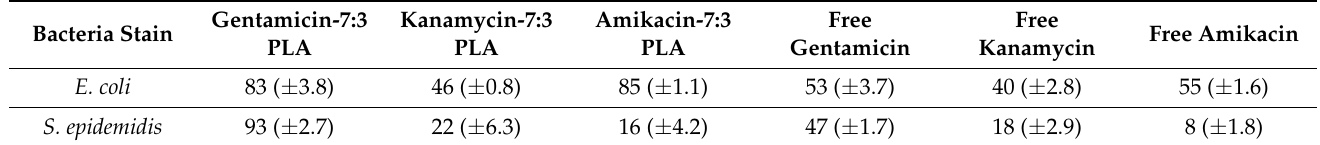
Figure 5. Antibacterial kinetic growth curves and inhibition (%) of non-porous PLA (control) and AD-loaded porous 7:3 PLA against ( a , c ) E. coli and ( b , d ) S. epidermidis ; two-way ANOVA: o p < 0.05 amikacin versus kanamycin; ★ p < 0.05 kanamucin versus gentamicin; # p < 0.05 amikacin versus gentamicin. Table 2. Inhibition (%) of AD-loaded porous 7:3 PLA and free ADs against E. coli and S. epidermidis after 72